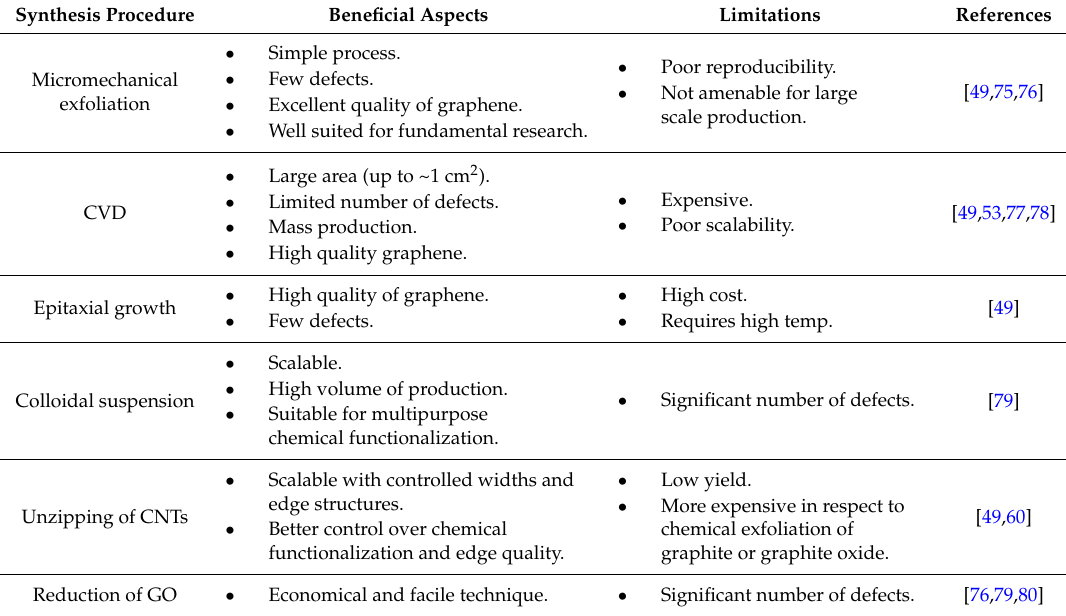
Table 2. Advantages and limitations of the major synthesis procedures of grapheme.